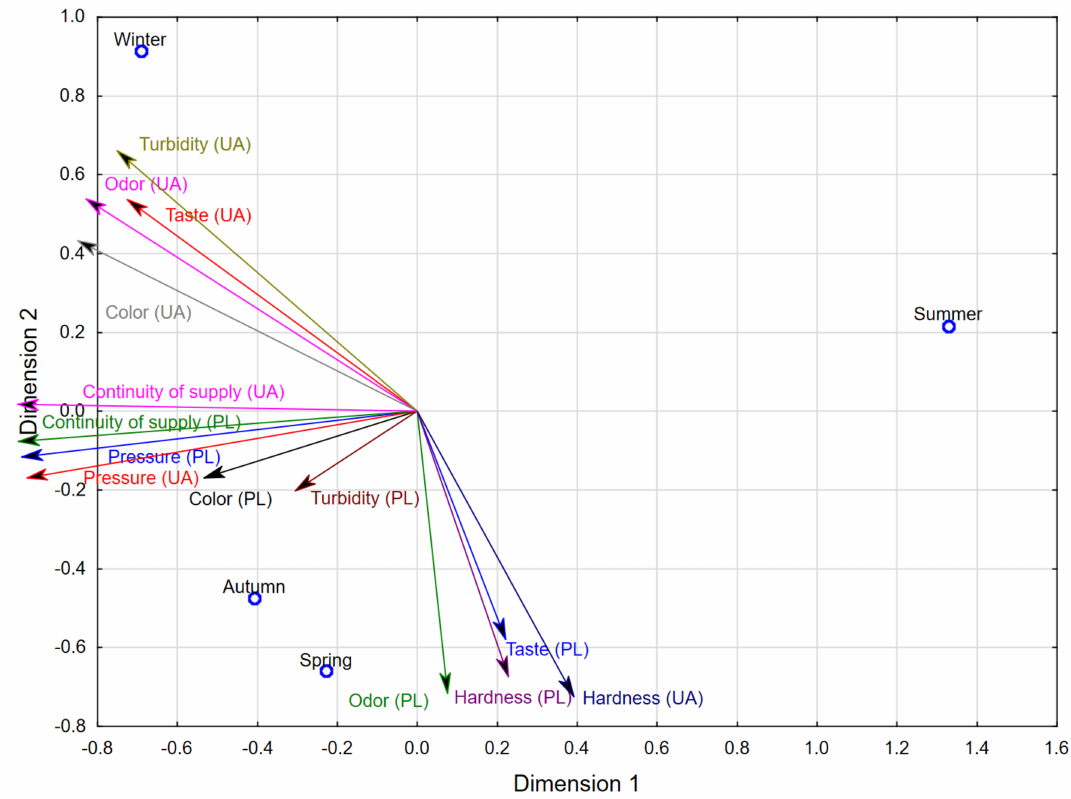
Figure 12. Biplot including the results of multidimensional scaling based on individual parameters of tap water supplied in Poland and